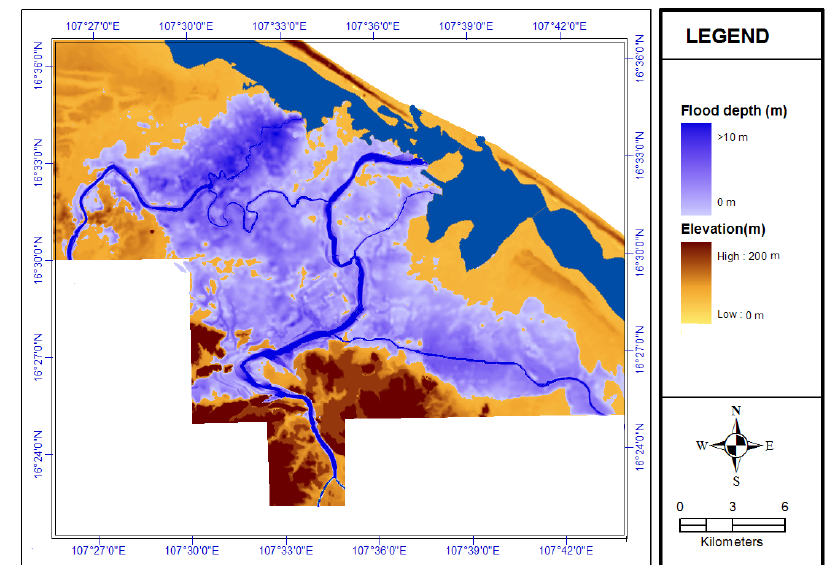
Figure 6. Predicted inundation map at 13:00 h on 12 November 2007, showing the extent of the inundation and resulting water depth (only the inundated part of the floodplain is shown).